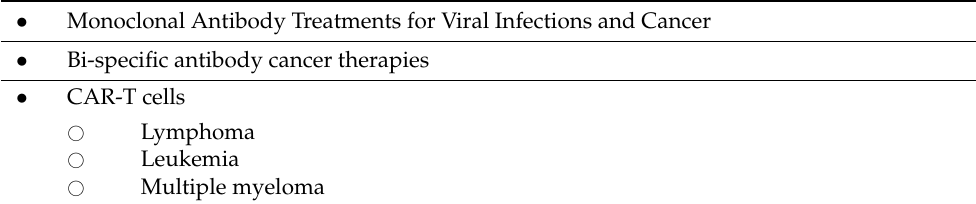
Table 3. Existing Antigen-Specific Immunotherapy